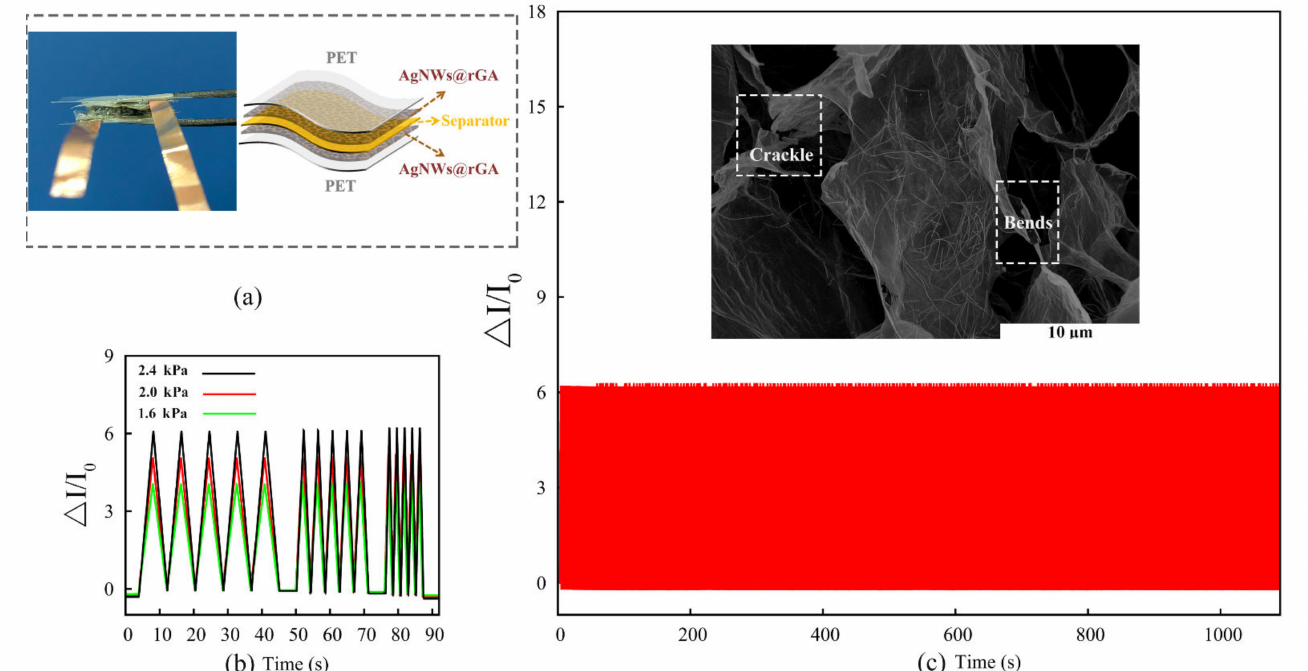
Figure 4. ( a ) Photograph of the assembled AgNWs@rGA//AgNWs@rGA wearable electronics and a graphic illustration of the piezoionic self-powering sensor. ( b ) Responding ∆ I/I 0 under loading pressure of 1.6, 2.0, and 2.4 kPa with different frequencies. ( c ) Compressing–releasing cycles of piezoionic self-powering sensor under the pressure of 2.4 kPa. The inset is the SEM of AgNWs@rGA after 1000 stress–strain